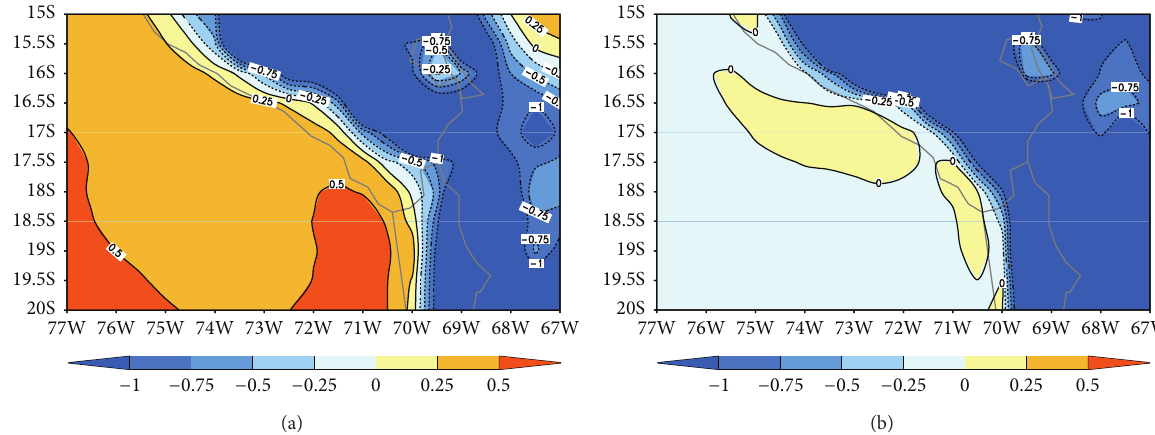
Figure 9: (a) El Ni˜no composite (El Ni˜no—neutral) for dew point shaded and contoured (units: standard deviation). (b) Like (a) except for La Ni˜na